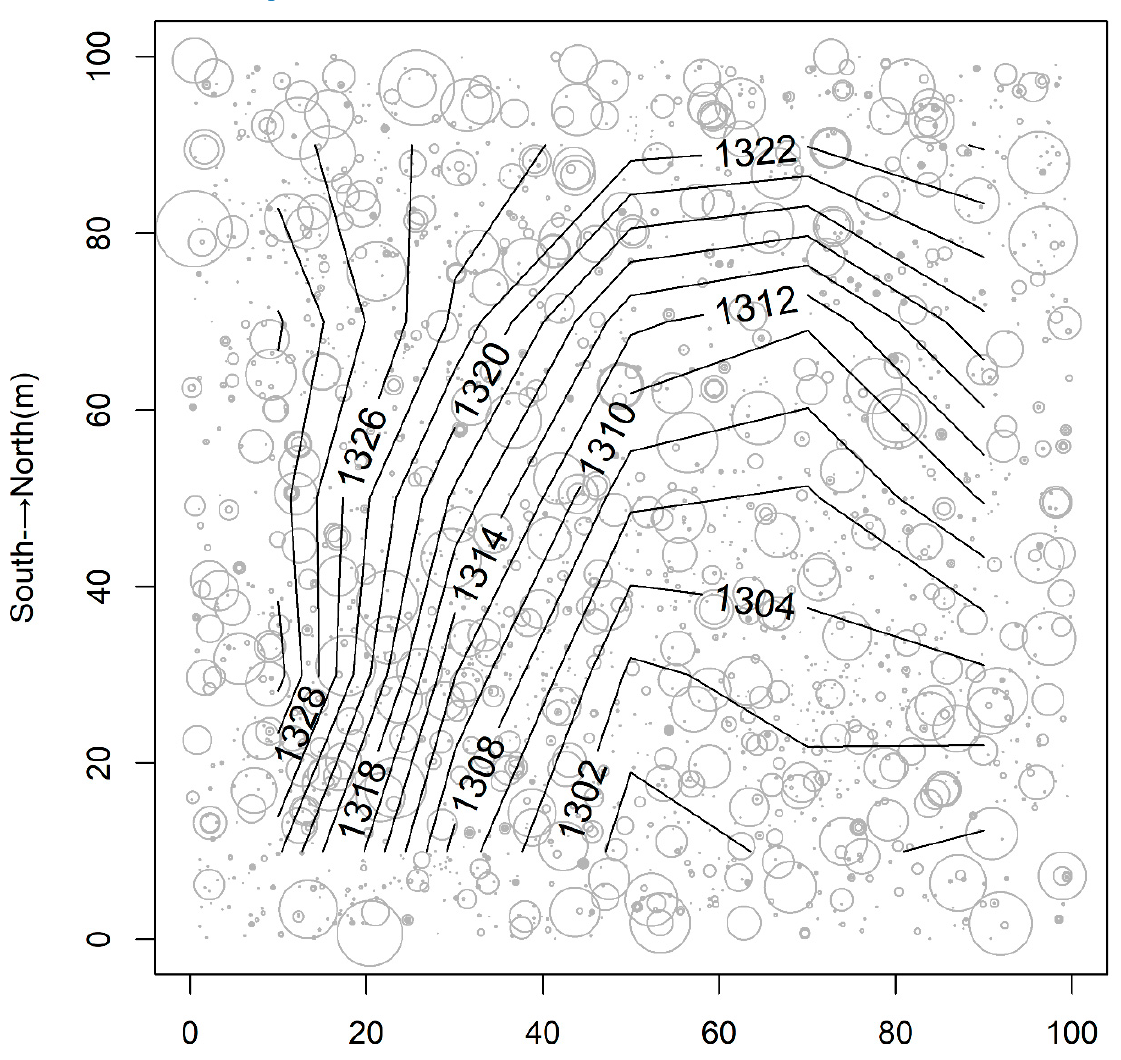
Figure 1. Spatial distribution of woody plant species in the plot. The circle sizes represent the diameter at breast height of the species. The black line shows the plot contours.